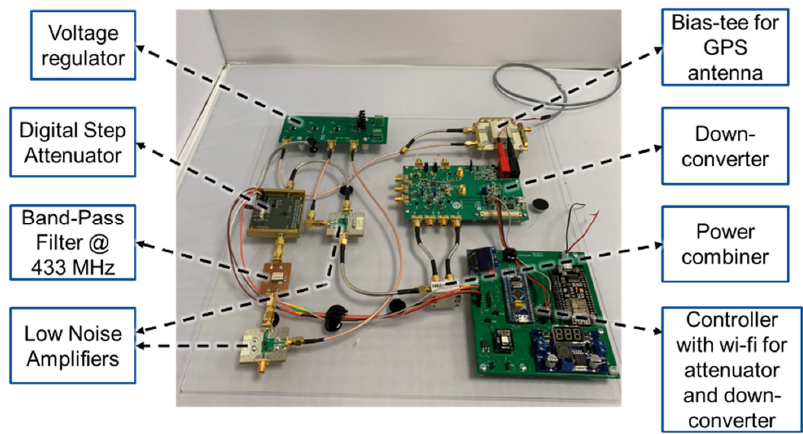
Figure 4. Implemented GPS down-converting repeater subsystem excluding the antennas.